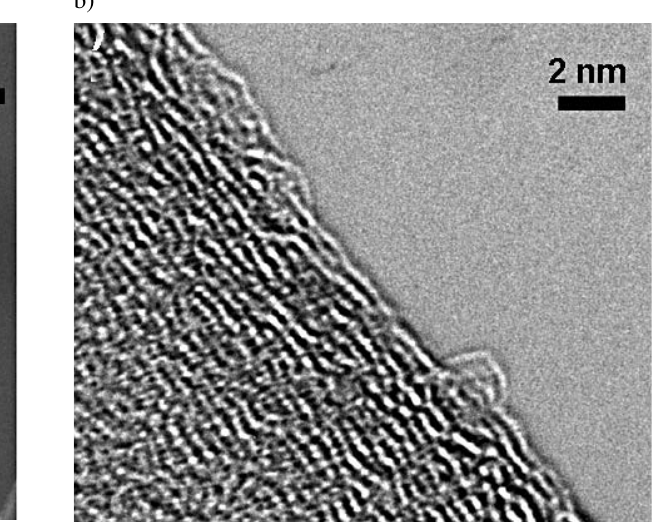
-GNRs . a) SEM image, b) TEM image 60